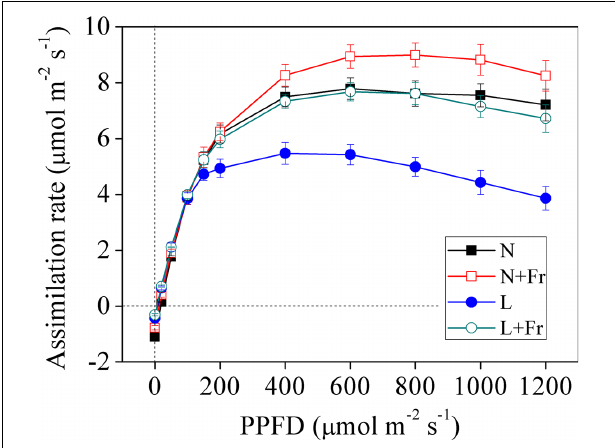
FIGURE 3 | Light response curves of net assimilation rate under different light intensity and quality treatments. N, N+Fr, L, and L+Fr denote normal light (normal PAR and normal R/Fr ratio), normal light plus far-red light (normal PAR and low R/Fr ratio), low light (low PAR and normal R/Fr ratio), and low light plus far-red light (low PAR and low R/Fr ratio), respectively. PPFD represents the photosynthetic photon quanta flux density. Each value is expressed as the mean ± SE.